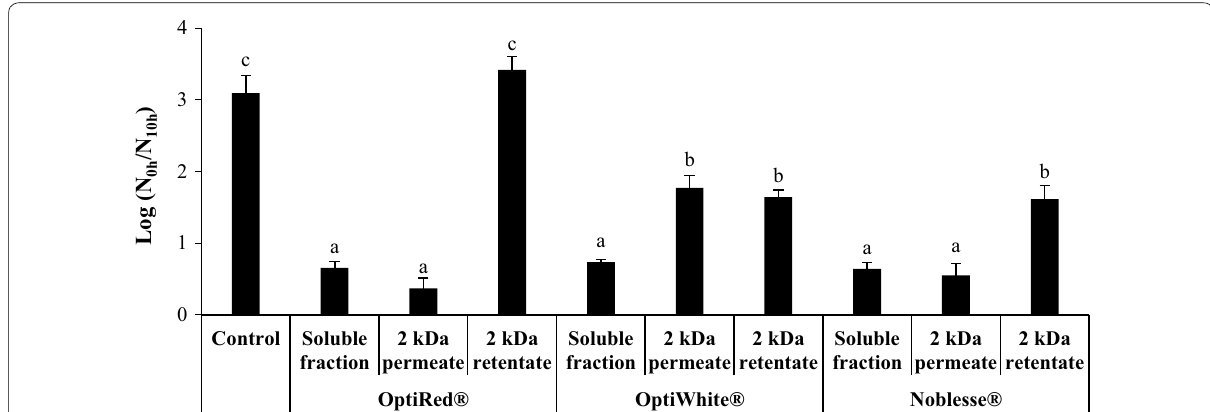
Fig. 3 Effect of 2 kDa membrane permeates and retentates of IYD supernatants on L. rhamnosus HN001 viability. Different lowercase letters indicate significant differences ( P < 0.05). Values are the mean of triplicate experiments ( n mean